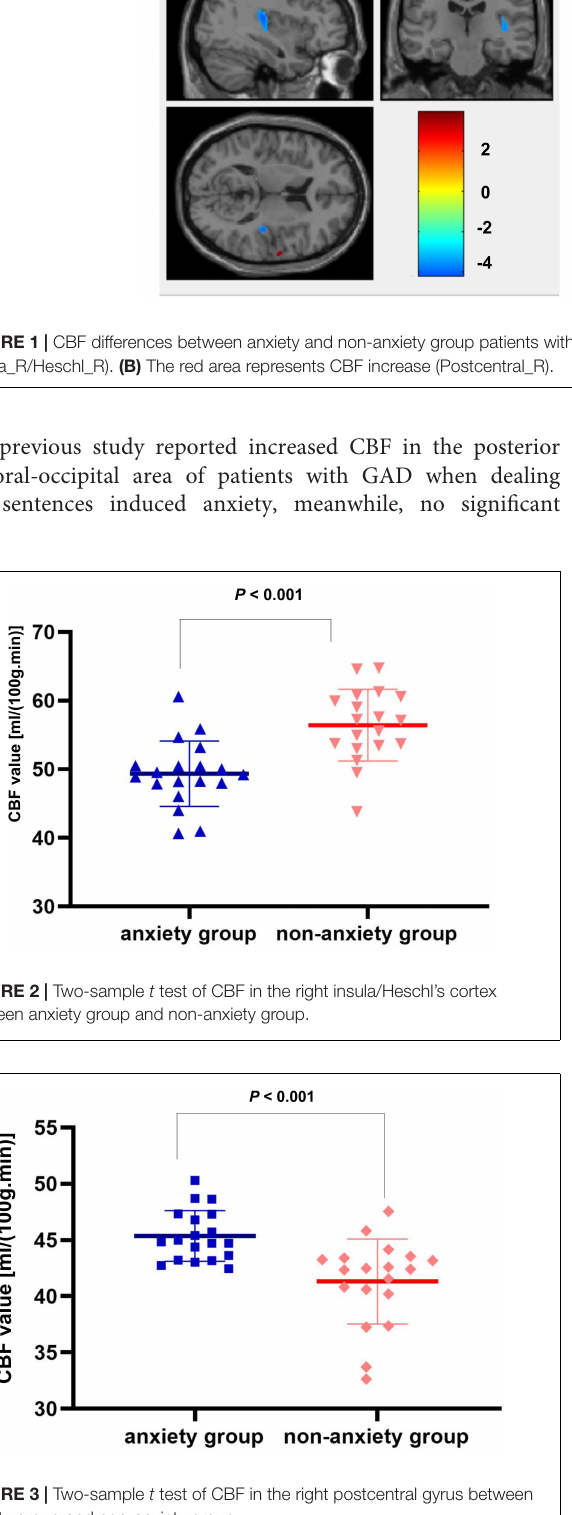
FIGURE 3 | Two-sample t test of CBF in the right postcentral gyrus between anxiety group and non-anxiety